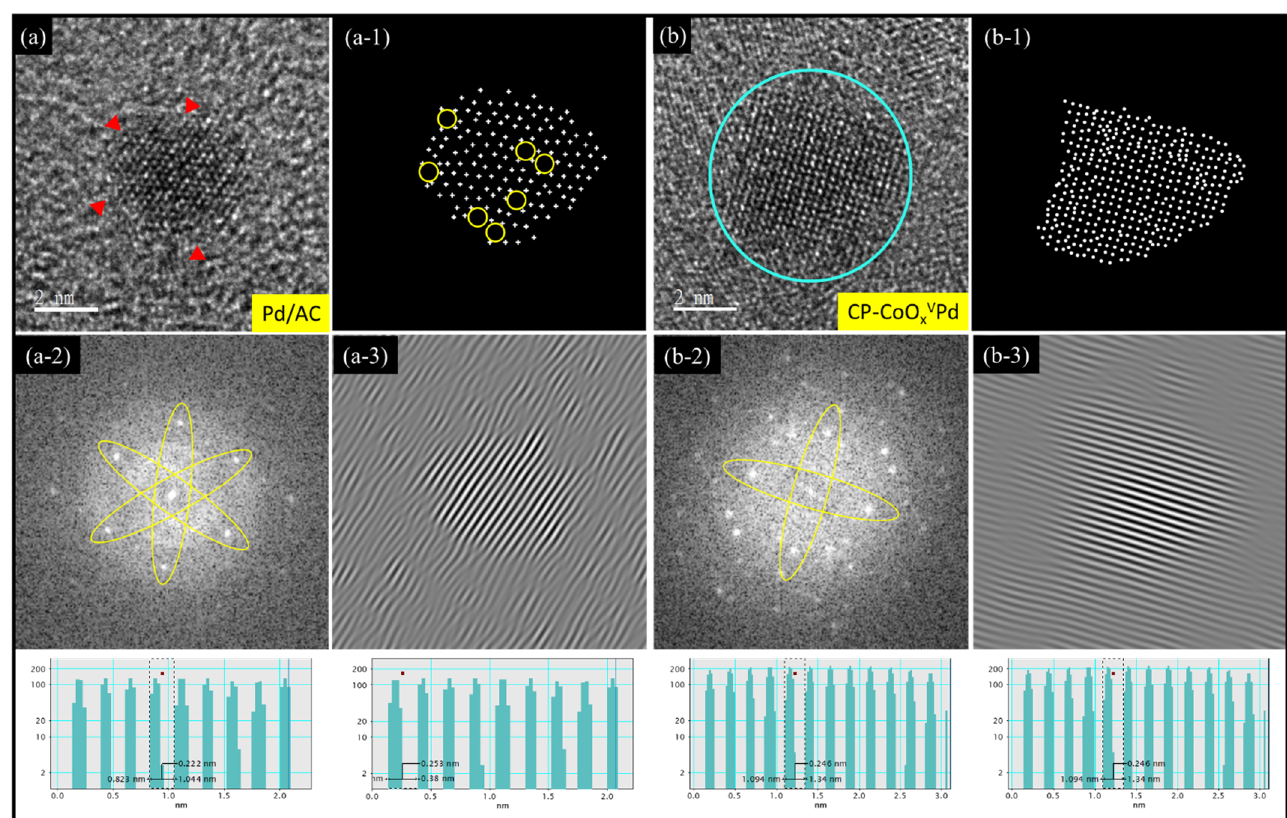
Figure 1. HRTEM images of as-prepared ( a ) Pd/AC and ( b ) CP-CoO xV Pd NCs. The digital image- processing results, forward Fourier transformation (FFT) patterns and inverse Fourier transform (IFT) images of the selected areas in HRTEM images are depicted in ( a1 , b1 ), ( a2 , b2 ), and ( a3 , b3 ), respectively, for Pd/AC and CP-CoO xV Pd NCs. The d-spacing values of experimental NCs are calculated using IFT images and their corresponding line histograms (insets).